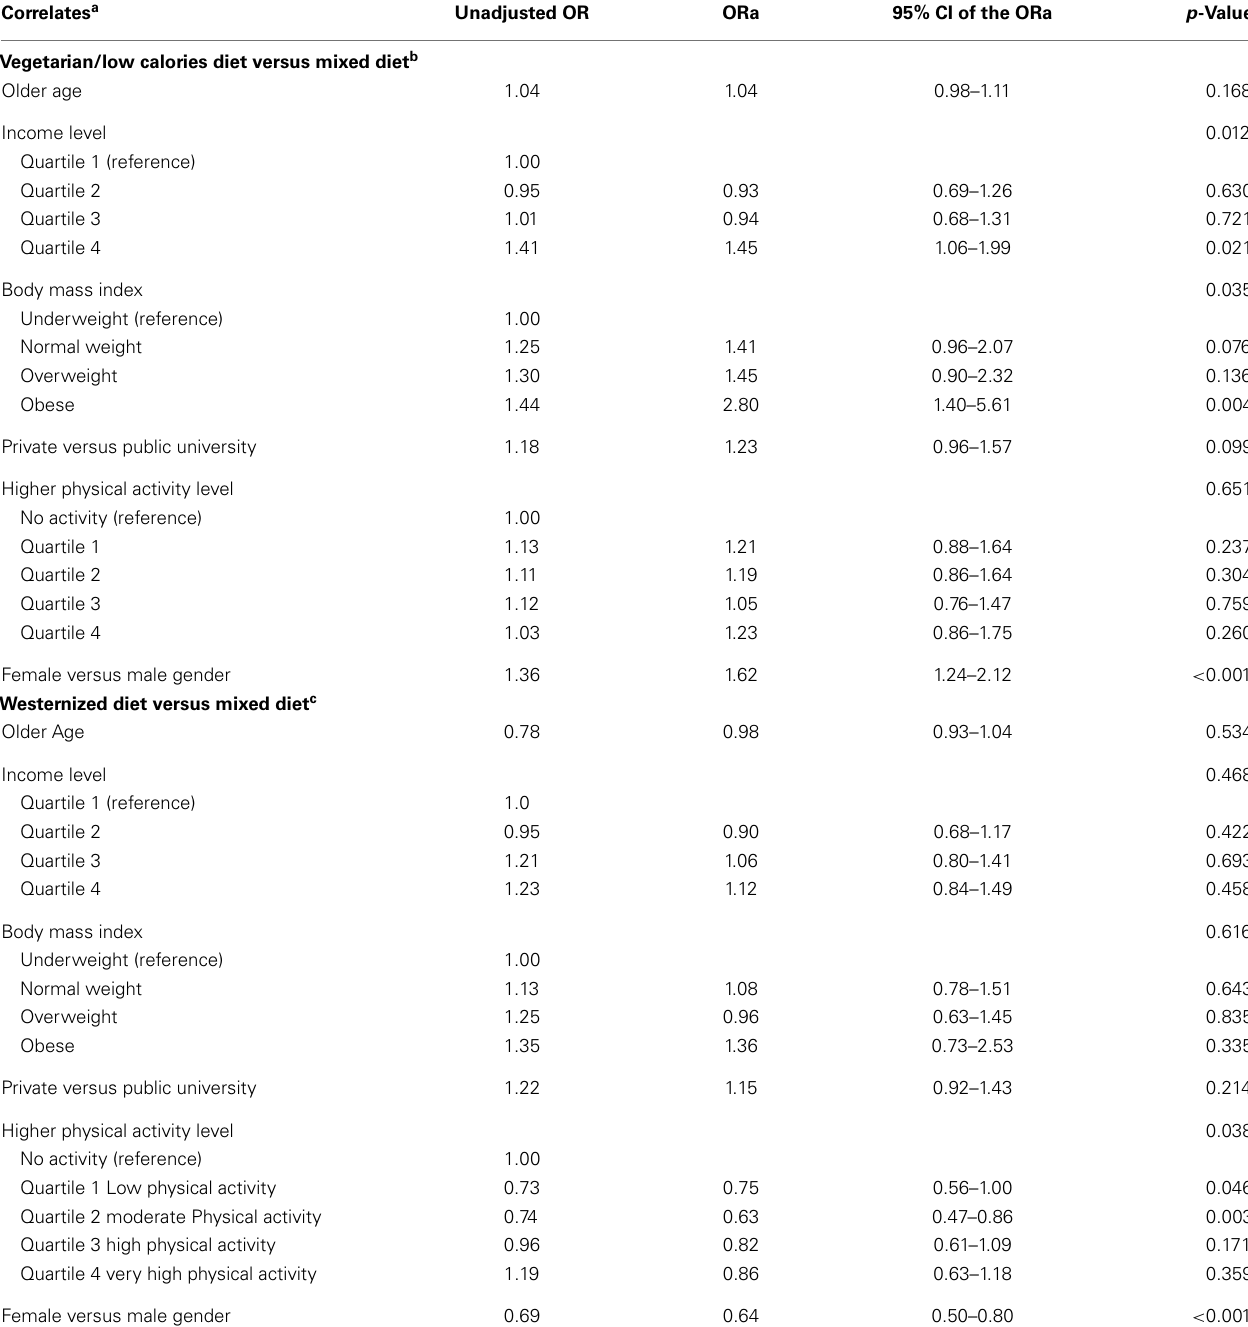
Table 6 | Correlates of dietary patters among university students: multivariate analysis